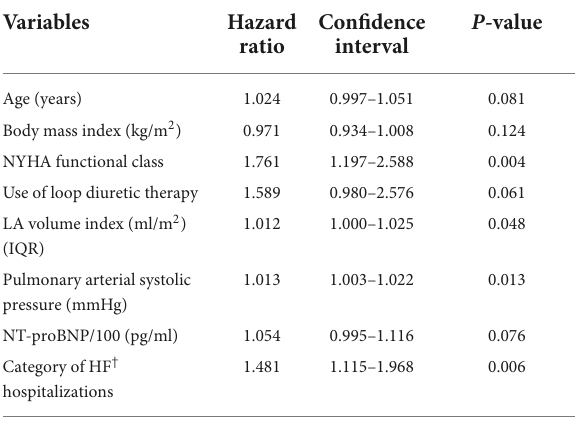
TABLE 2 Prediction model for all-cause death ( n =